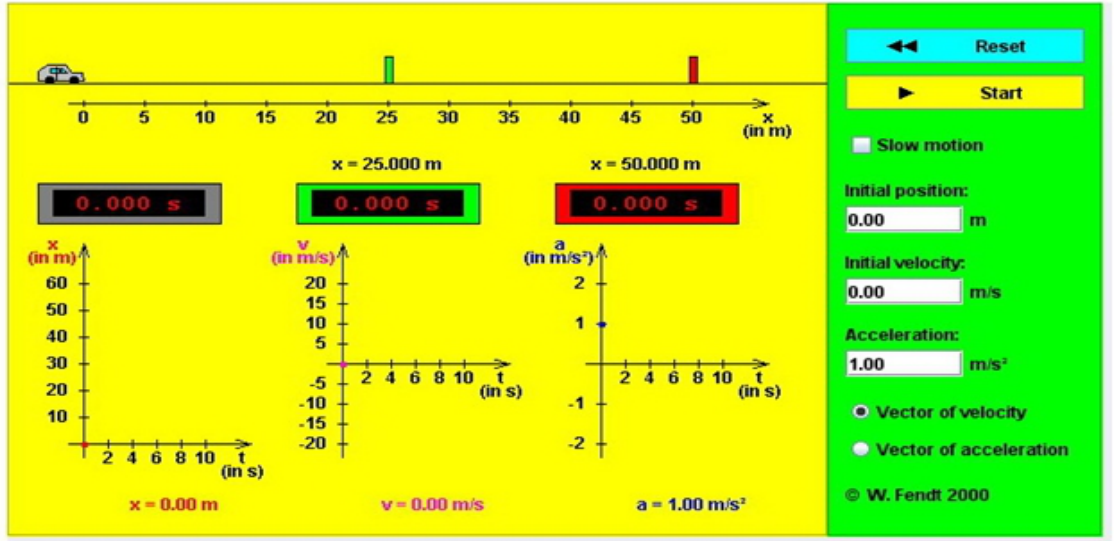
Figure 1. Initial display of applet No. 1, ‘Motion with constant acceleration’